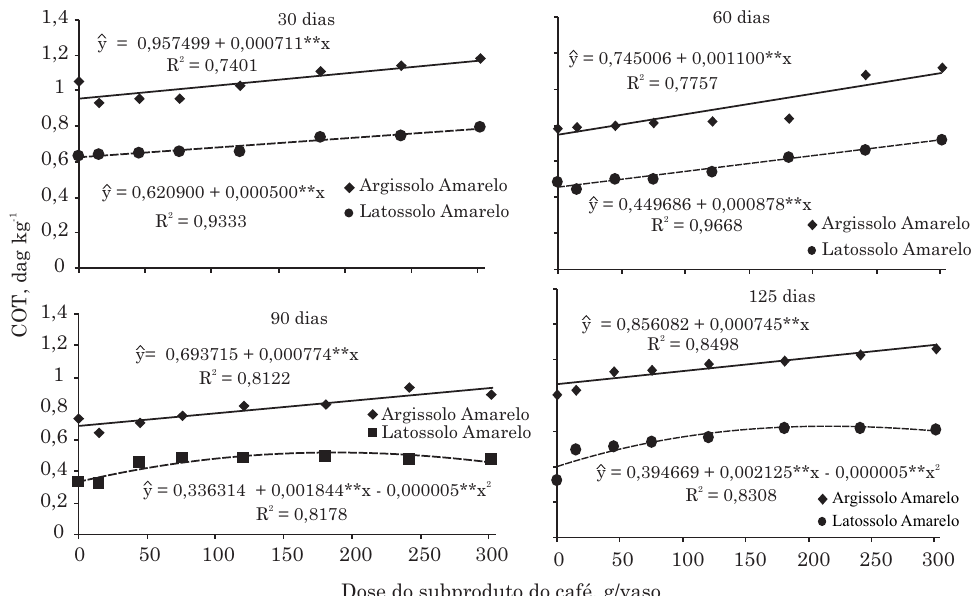
Figura 4. Carbono orgânico total (COT) aos 30, 60, 90 e 125 dias de incubação nas amostras do Argissolo Amarelo e Latossolo Amarelo, em função da aplicação de doses de subproduto de café e sob o cultivo de